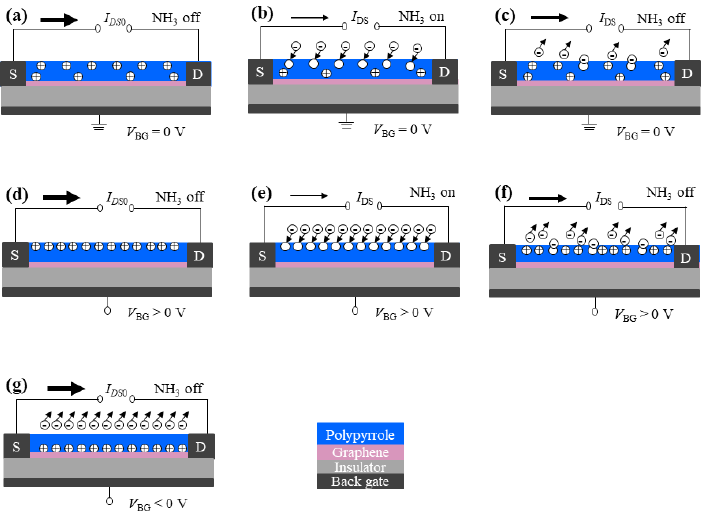
Figure 1. Schematic cross-sections of the PPy/G FET sensor presenting the measurement principle for NH 3 detection under different polarities of the back-gate voltages (V BG ). ( a – c ) The PPy/G FET sensor was equivalent to a chemiresistor when V BG = 0 V. ( d – f ) A positive back-gate voltage pushed holes into the channel surface and then attracted more electrons from NH 3 , significantly decreasing the channel current, and thereby promoting the sensor response. ( g ) A negative back-gate voltage forced the donated electrons back to NH 3 and restored the channel current to its initial value, thereby accelerating sensor recovery.